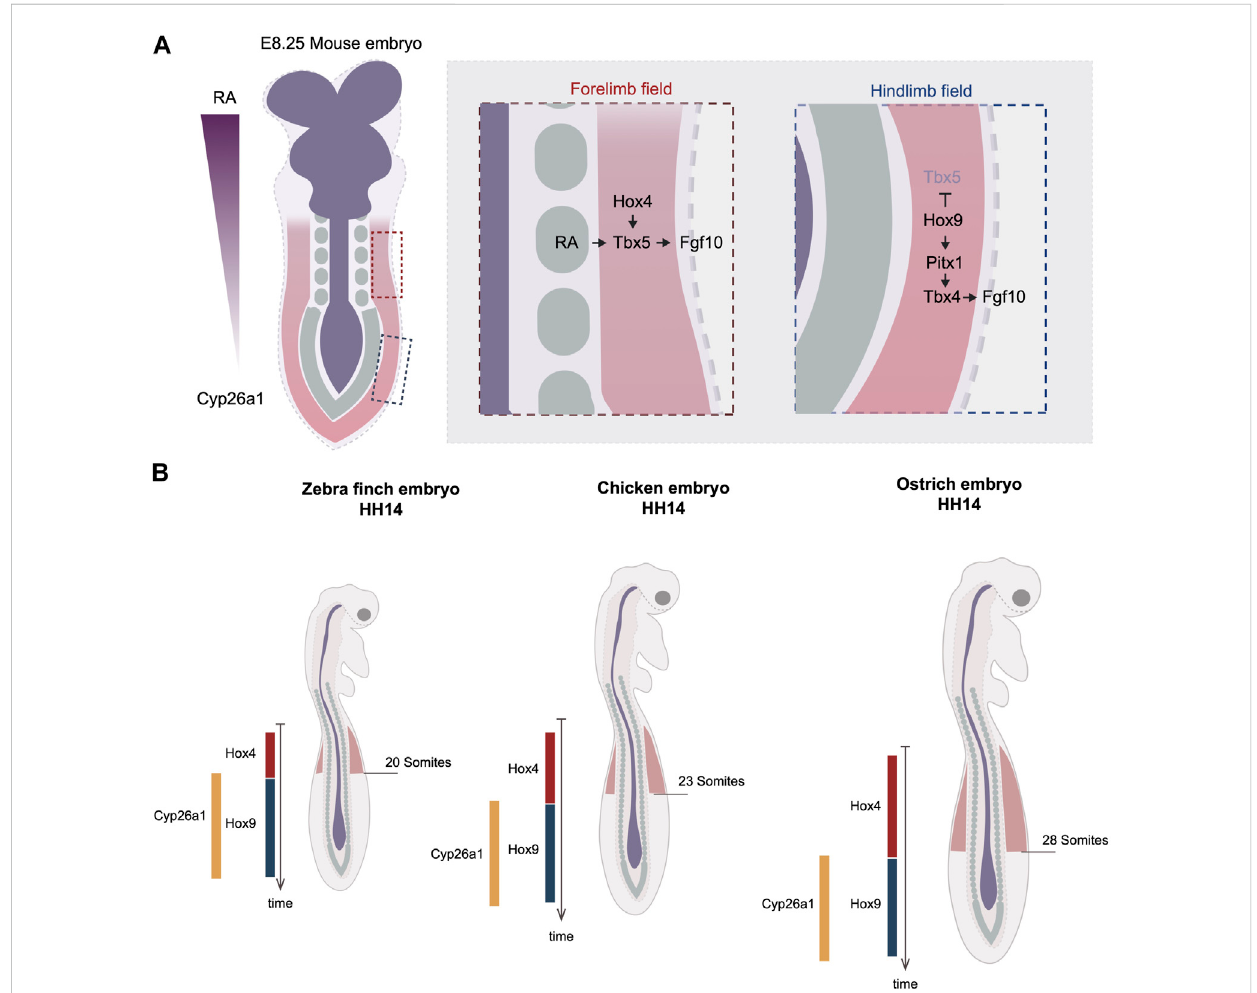
FIGURE 1 TimingvariationsintheonsetoflimbdevelopmentbytheregulationofHoxcode. (A) RostraltocaudalRAgradientregulatesthecollinearHoxgenes expression at the axial level. In the anterior region, Hox4 speci fi es the forelimb fi eld by activating the expression of Tbx5. The RA molecules emanating fromthetrunk canactivate Tbx5 inparallel ofHox. Intheposteriorregion,Hox9antagonizesTbx5 ’ sexpression and inducetheexpressionofPitx1,which activates Tbx4. Dark blue labels neuroectodermal tissues, green labels somites and red regions level the lateral plate mesoderm. (B) The timing of hox genes ’ expression varies between three avian species, quail, chicken, and turkey. The delayed termination of Hox4 leads to posterior expansion of forelimb position in turkey. The varied timing of hox genes ’ expression is linked to the timing of RA degradation enzyme, Cyp26a1. Red regions indicate forelimb fi